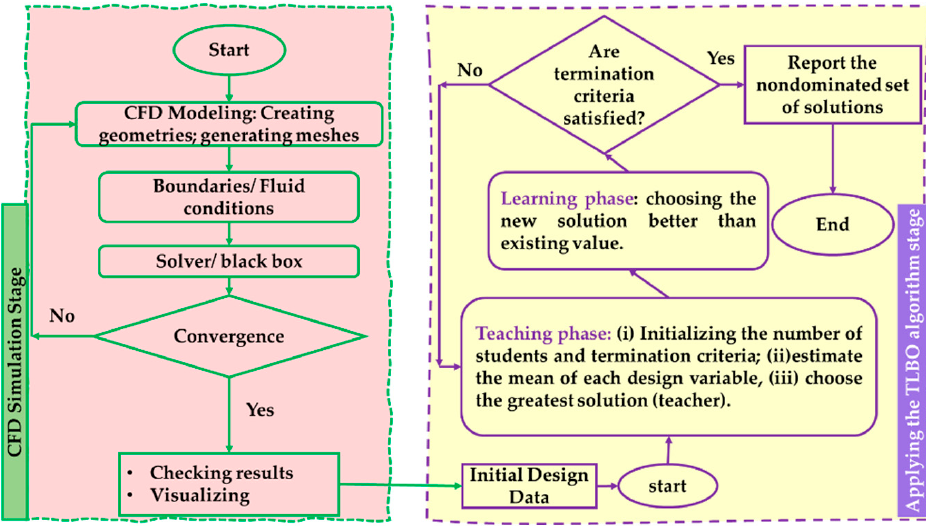
Figure 8. Flowchart of the optimal design.